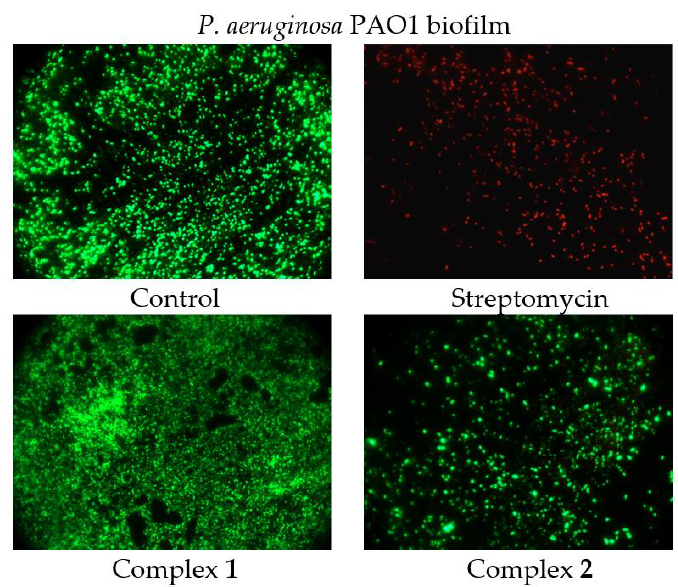
Figure 7. Epifluorescence microscopy images of P. aeruginosa PAO1 biofilm treated with 1 mM of arene Ru(II) complexes. Biofilm was stained with nucleic acid stains using the FilmTracer™ LIVE/DEAD Biofilm Viability Kit (live cells are represented by the color green; dead cells are represented by the color red). The epifluorescence microscopy images were captured at 1000× magnification.